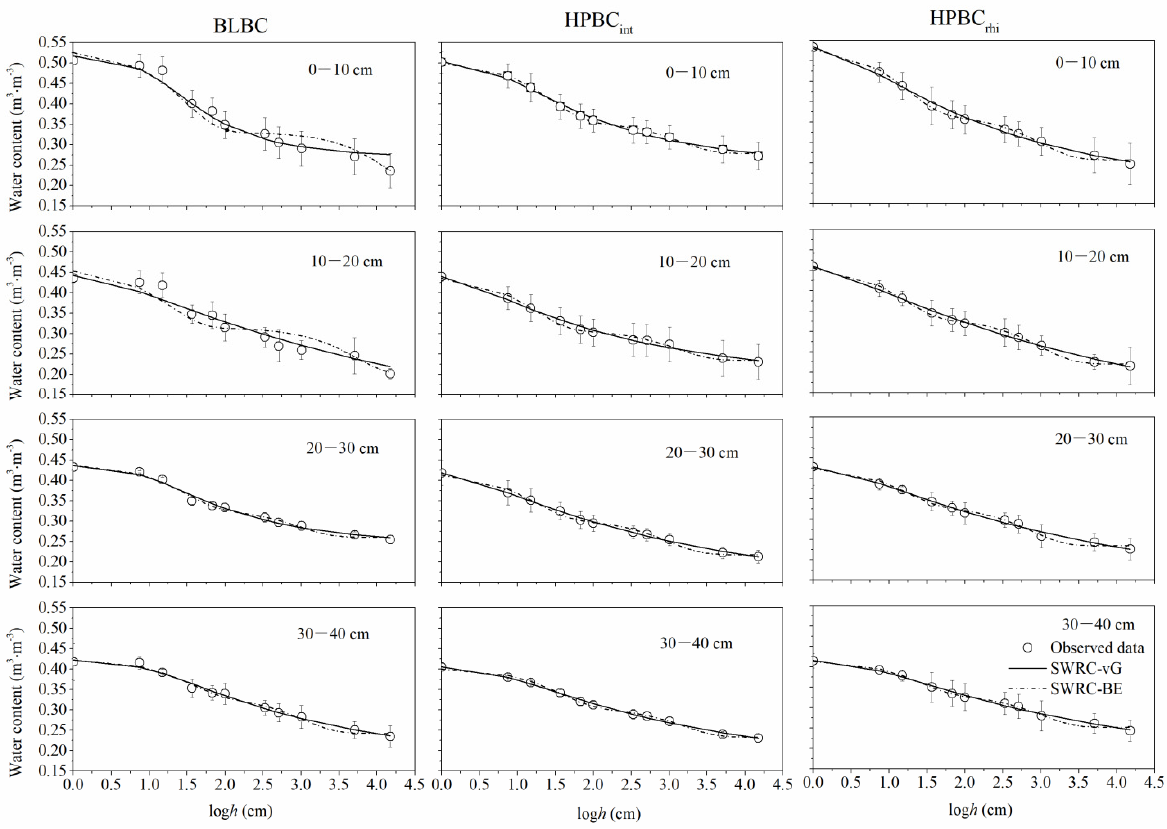
Figure 4. Comparison of the soil water retention curves obtained by fitting the single porosity van Genuchten (1980) model (SWRC-vG) and biexponential model (SWRC-BE) to water retention data measured on soil core samples collected from plot BLBC, inter-row location (HPBC int ), and honeysuckle planted location (HPBC rhi ) of plot HPBC.